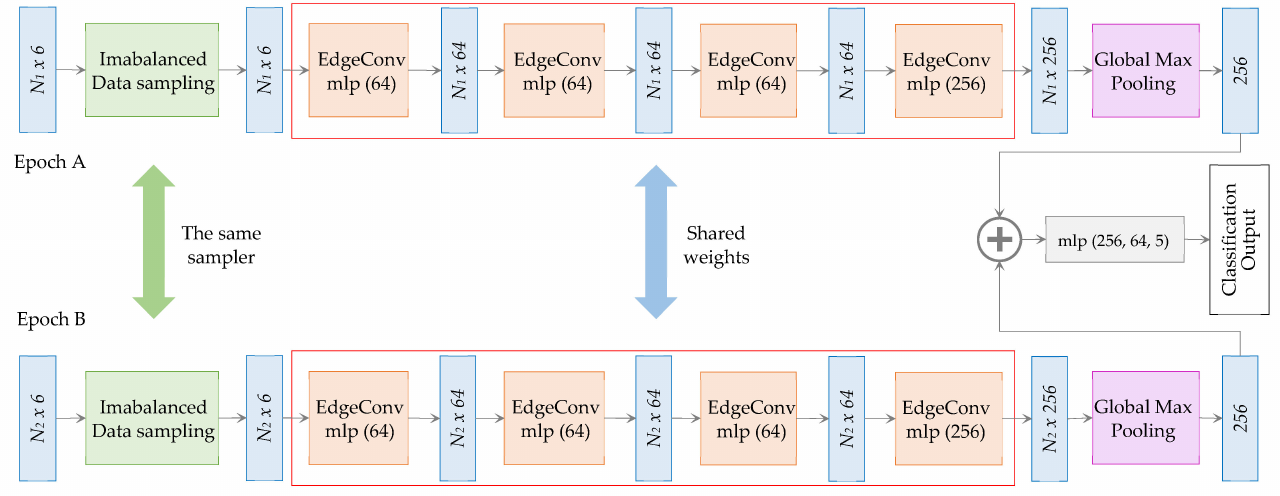
Figure 10. SiamGCN network architecture, as described in